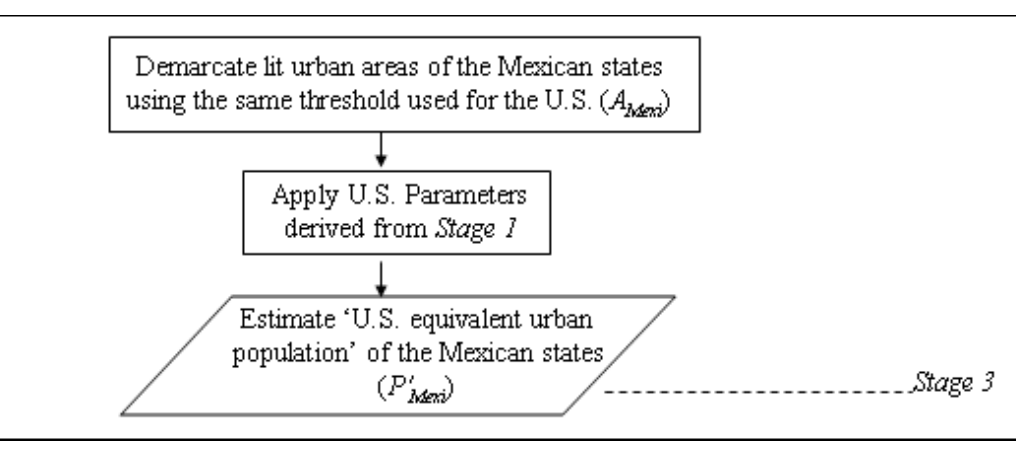
of the U.S. states. USi